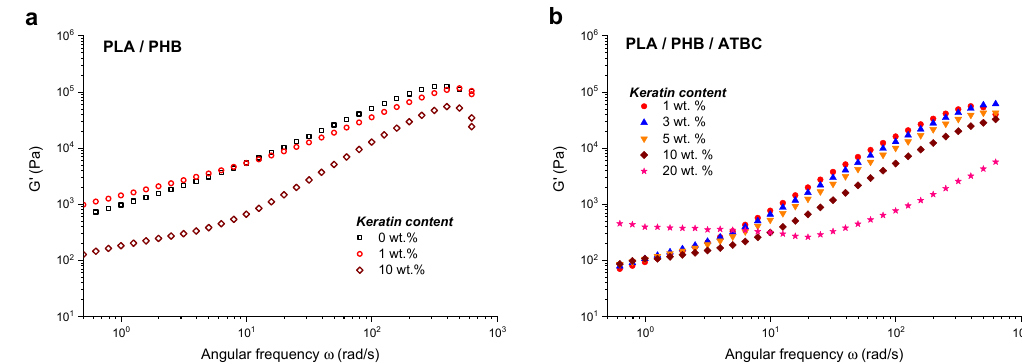
Figure 5. Dependencies of storage modulus G ′ vs. frequency for ( a ) neat PLA/PHB blend without keratin and with 1 wt % and 10 wt % of keratin loading and ( b ) PLA/PHB/ATBC blend with 1 wt %, 3 wt %, 5 wt %, 10 wt % and 20 wt % of keratin loading.